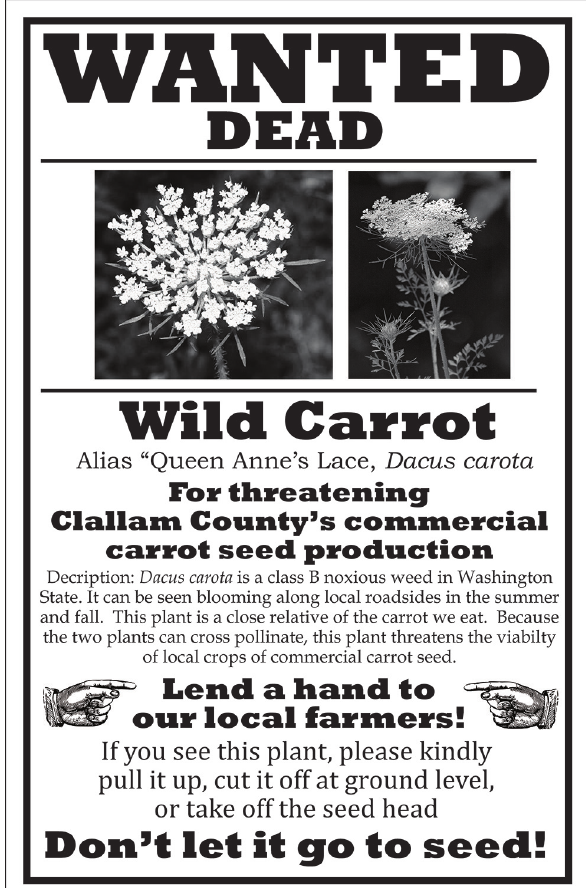
Figure 3: This poster is an example of the educational materials created by the WSU Extension office as part of the outreach campaign conducted by Master Gardeners to raise awareness about the problem of wild carrot in the Dungeness Valley. Image created by the